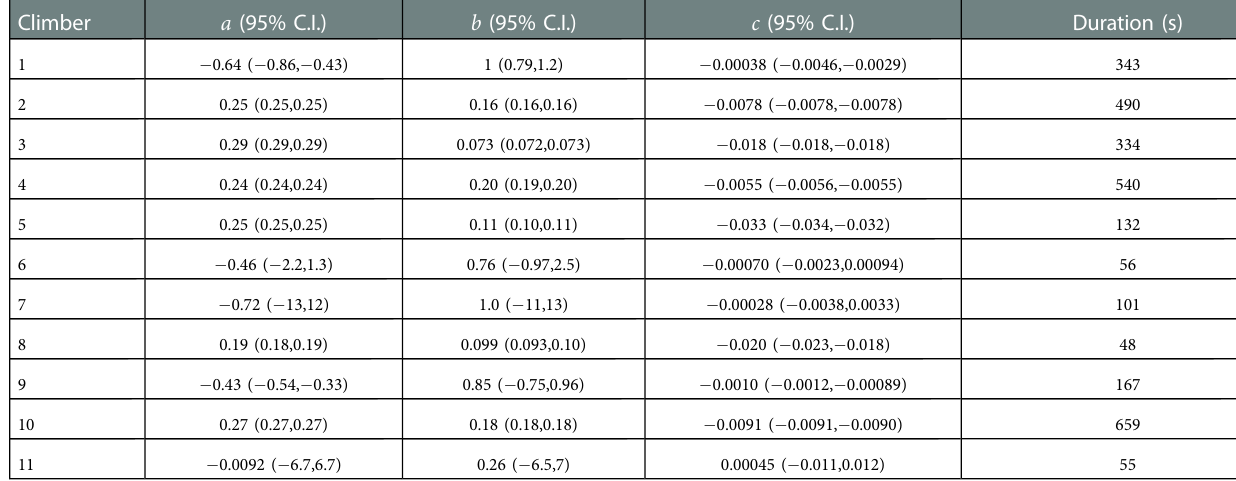
TABLE 5 Coef fi cients of a nonlinear least square fi t of the function a þ be ct to the curves in Figure 10, 95 % con fi dence interval bounds of the coef fi cients, and the duration of the exercise. a Climber a (95% C.I.) b (95%